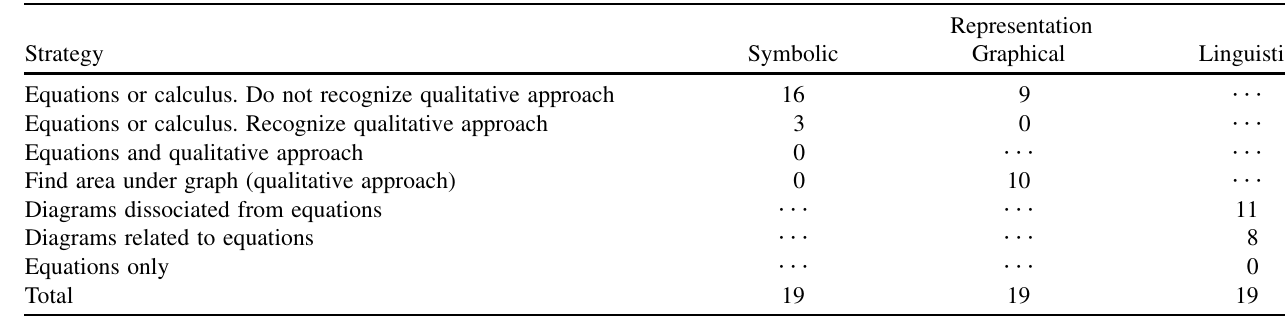
TABLE V. Strategy when solving for a quantitative solution from symbolic, graphical and linguistic representations in work.